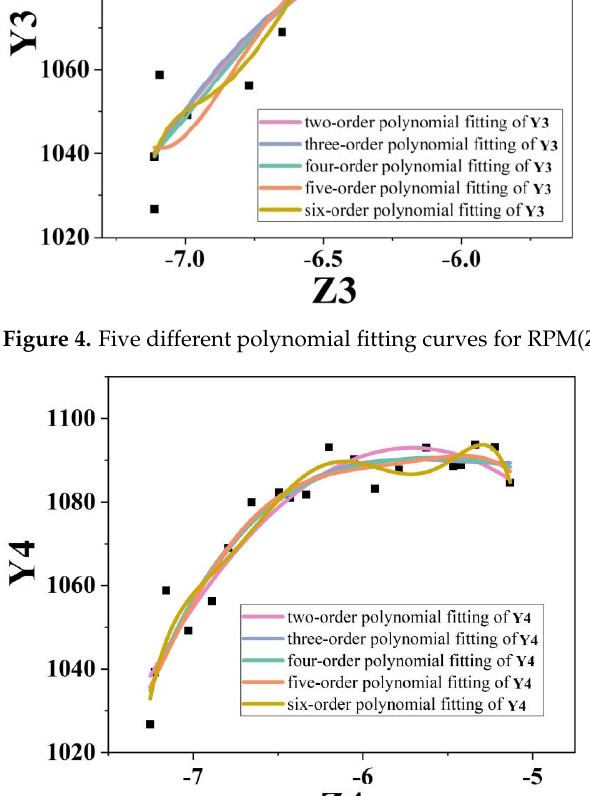
Table 5. The error of different multi-order polynomial for EGT2.